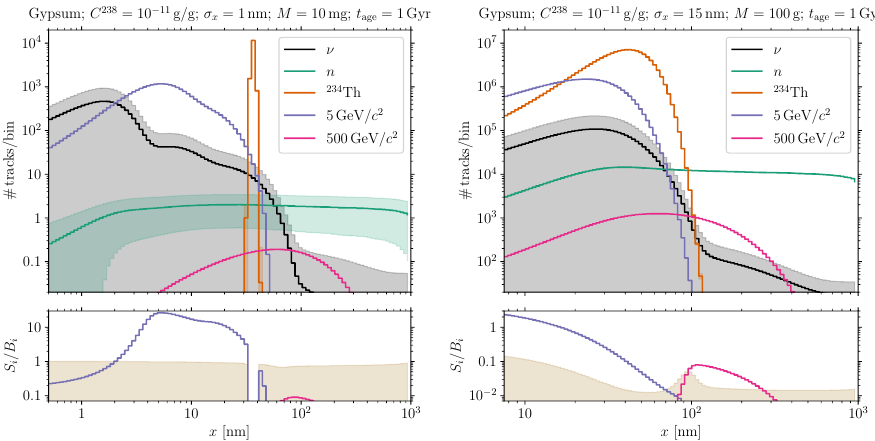
Figure 2. Track length spectra for a 5GeV/c 2 and a 500 GeV/c 2 WIMP compared to the background 234 Th + α recoils ( 234 Th ) spectra induced by neutrinos ( ν ), radiogenic neutrons ( n ), and 238 U → after taking finite resolution effects into account. The left panels are for our high resolution scenario ( M = 10mg of sample material read out with track length resolution of σ x = 1nm), while the right panels are for the high exposure scenario ( M = 100g, σ x = 15nm). We assume that the samples have been recording tracks for t age = 1Gyr. In all panels, we use 100 logarithmically spaced bins x between σ x /2 10 3 nm; note that these bins and the scales of the axes differ between the left and ≤ ≤ the right panels. The upper panels show the number of tracks per bin from the respective sources. For the backgrounds, the shaded bands around the respective spectra show the associated error (systematic and statistical added in quadrature). The bottom panels show the ratio of the number of signal ( S i ) to the (summed) number of background ( B i ) events per bin, and the sand-colored shade shows the relative uncertainty of the total number of background events per bin. The signal-to-noise ratio per bin can be read off from the lower panels by dividing S i / B i for the respective signal with the relative uncertainty of the background. For the normalization of the WIMP DM spectra, we set the spin-independent WIMP-nucleon cross sections to σ SI p = 10 − 43 cm 2 for the 5GeV/c 2 case and σ SI p = 10 − 46 cm 2 for the 500GeV/c 2 case, as in Figure